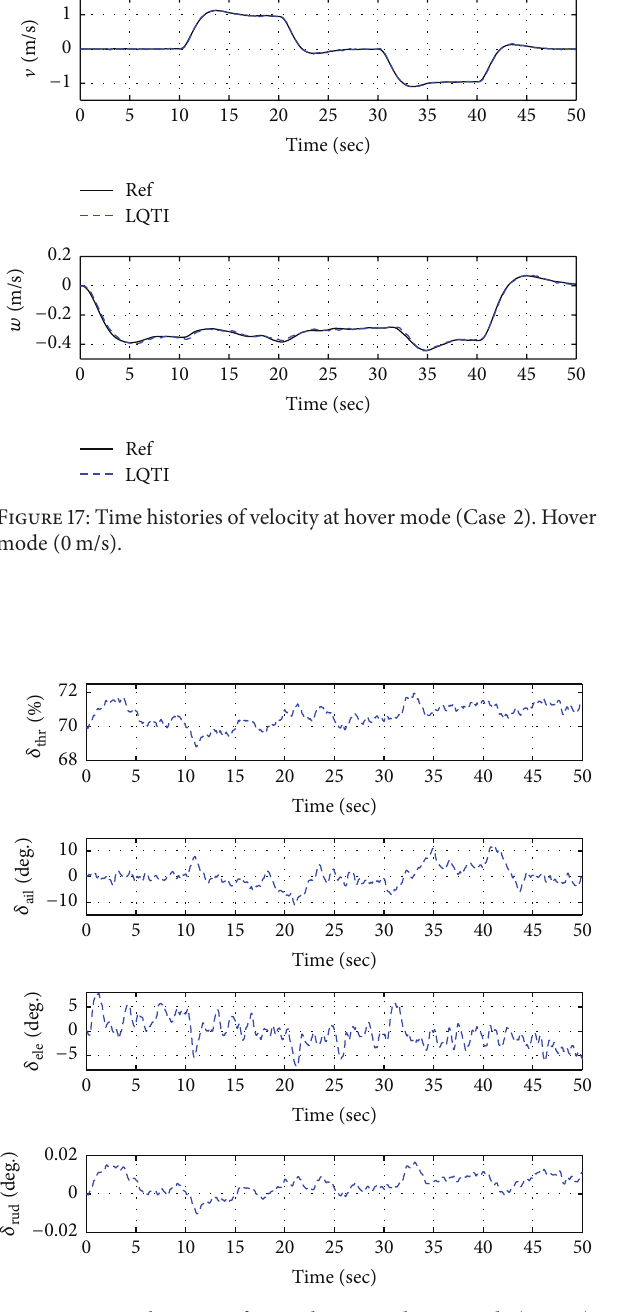
Figure 18: Time histories of control inputs at hover mode (Case 2). Hover mode (0 m/s).